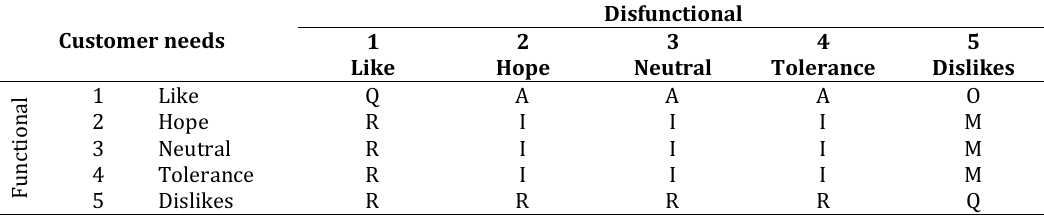
Table 3: Kano Category Assessment